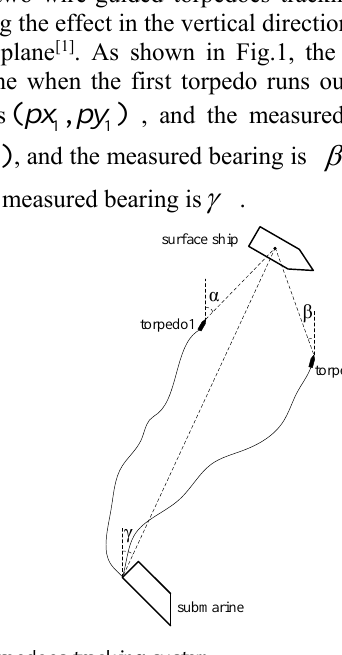
Fig. 1. Two wire-guided torpedoes tracking